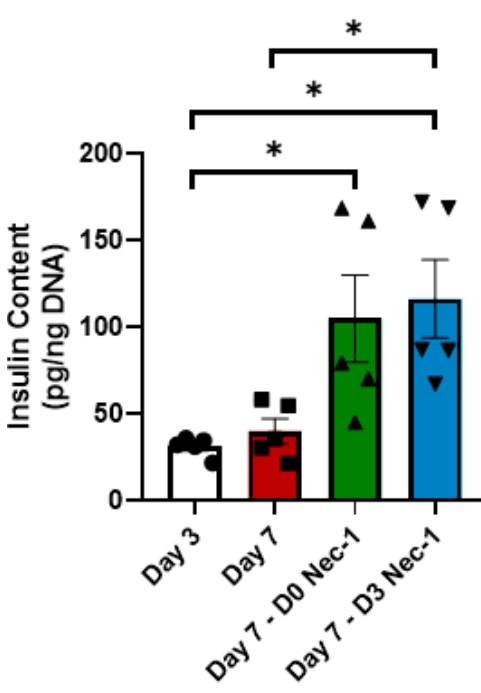
Figure 5. Insulin Content of PPIs on day 3 and 7 of tissue culture in control media or media supplemented with Nec-1 either immediately after islet isolation (D0 Nec-1) or on day 3 of tissue culture (D3 Nec-1). 150 IEQs per isolation was lysed, sonicated, and evaluated for insulin content on day 3 and 7 of tissue culture using standard porcine insulin ELISA. The amount of insulin was normalized to the sample DNA content. n = 5 for each group. * p < 0.05. Individual data points for islets cultured in control media on day 3 (Day 3) or day 7 of tissue culture (Day 7) or in media supplemented with Nec-1 either immediately after islet isolation (D0 Nec-1) or on day 3 of tissue culture (D3 Nec-1) are shown within each bar graph as either circles, squares, triangles, or inverted triangles, respectively. Data expressed as mean ±